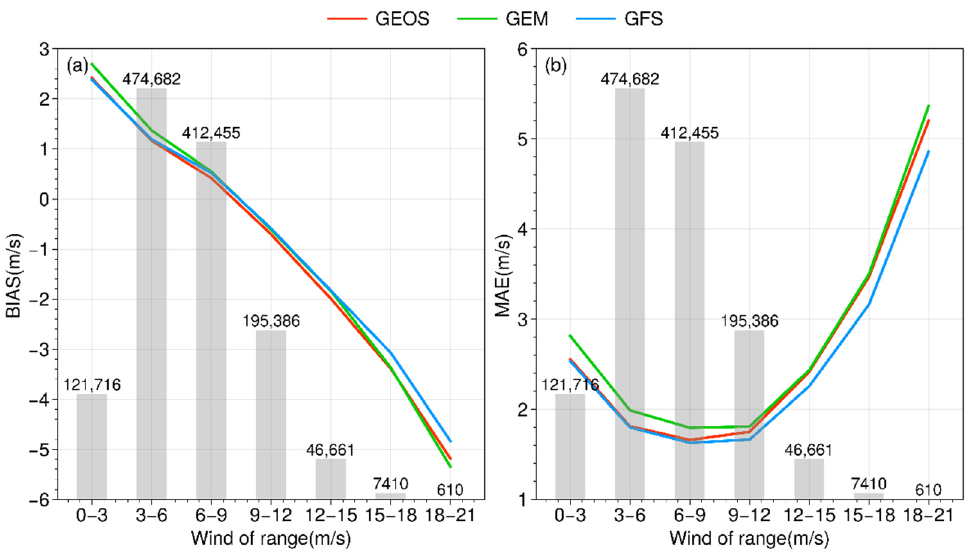
Figure 4. ( a ) BIAS and ( b ) MAE of the wind forecasts of the ensemble groups driven by the GFS, GEOS, and GEM. The line charts are the error statistics, and the histograms correspond to the number of data samples.